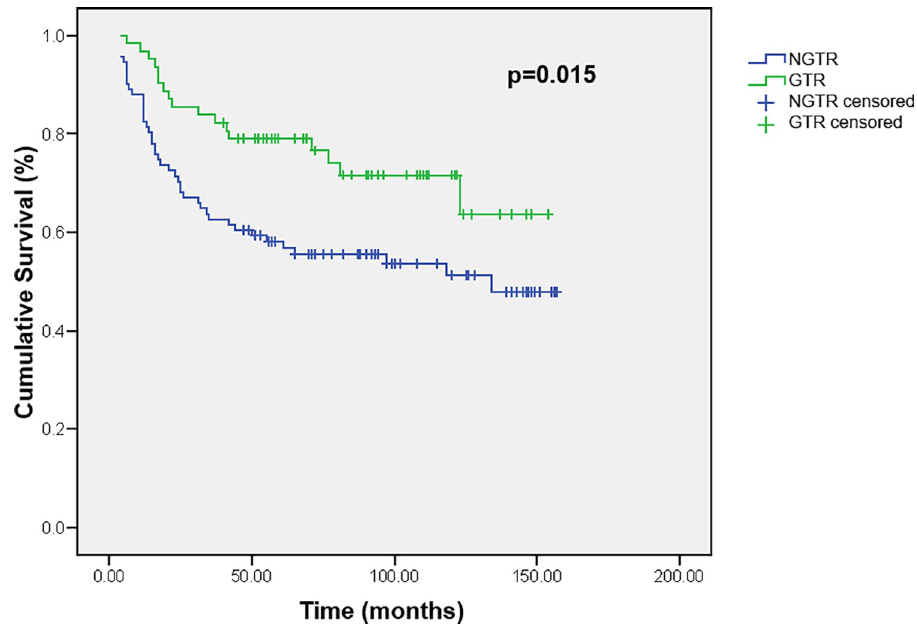
Fig 5. Cumulative survival of children with brain tumors according to type of resection. GTR–gross total resection, NGTR–non-gross total resection.